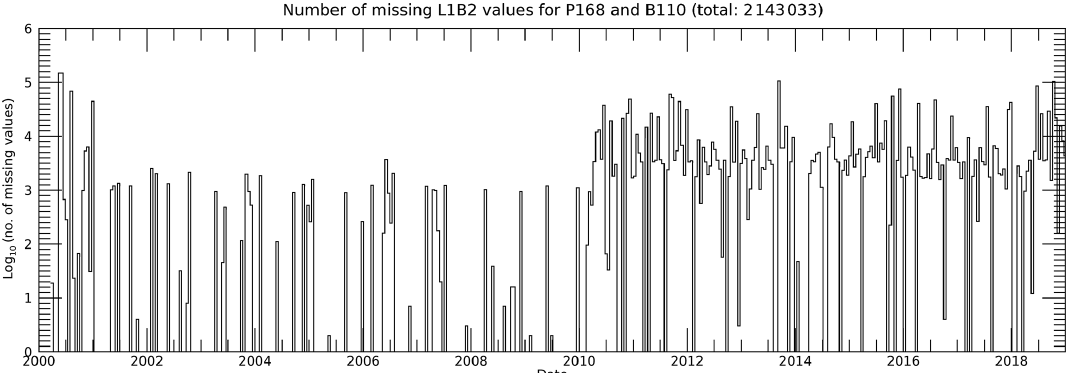
Figure 3. Time series of the logarithm in base 10 of the number of missing pixel values in the four spectral bands of the nine cameras of B LOCK 110 from each available MISR L1B2 GRP O RBIT in P ATH 168 between March 2000 and December 2018. This B LOCK includes the Skukuza flux tower located in Kruger National Park in South Africa. L OCAL M ODE data were briefly acquired at the start of the mission to support the Safari-2000 campaign and then systematically from December 2009 onward. It can be seen that there is a strong relationship between the number of missing values and the acquisition of L OCAL M ODE data, although the latter is not the only process responsible for missing